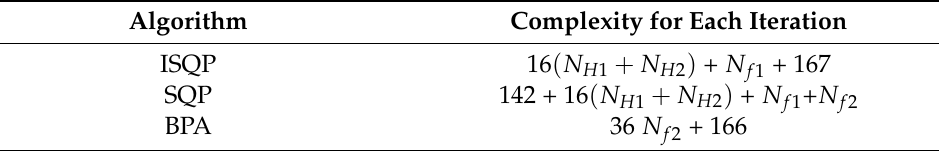
Table 4. Complexity Analysis for MIMO under Perfect Channel Estimation.